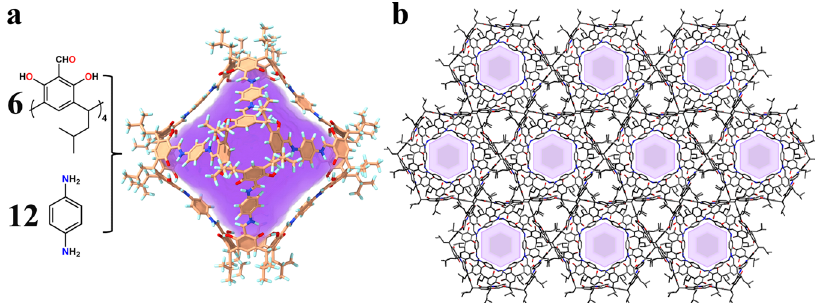
Fig. 1 Schematic illustration for assembly of CPOC-301. a The X-ray crystal structure of CPOC-301. b The solid-state molecular packing of CPOC-301 viewed from [001] direction, where H atoms are omitted for clarity. color codes: phenyl ring; orange, carbon; gray, oxygen; red, nitrogen; blue, and hydrogen; light